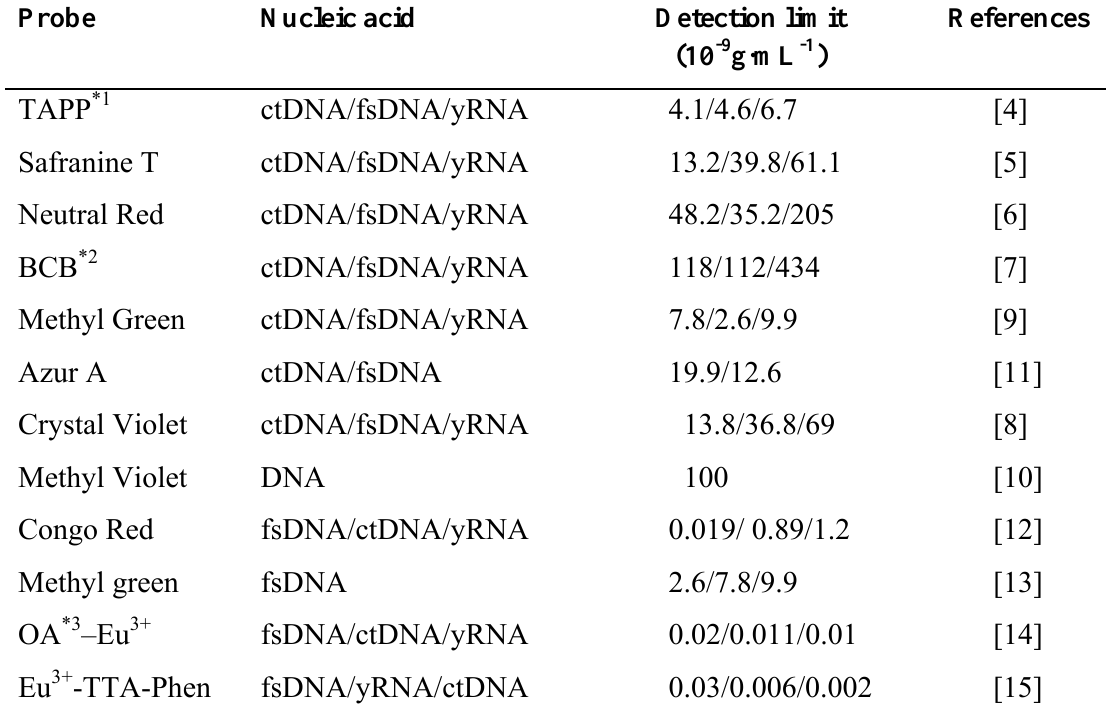
Table 3 . Different probes of nucleic acid by